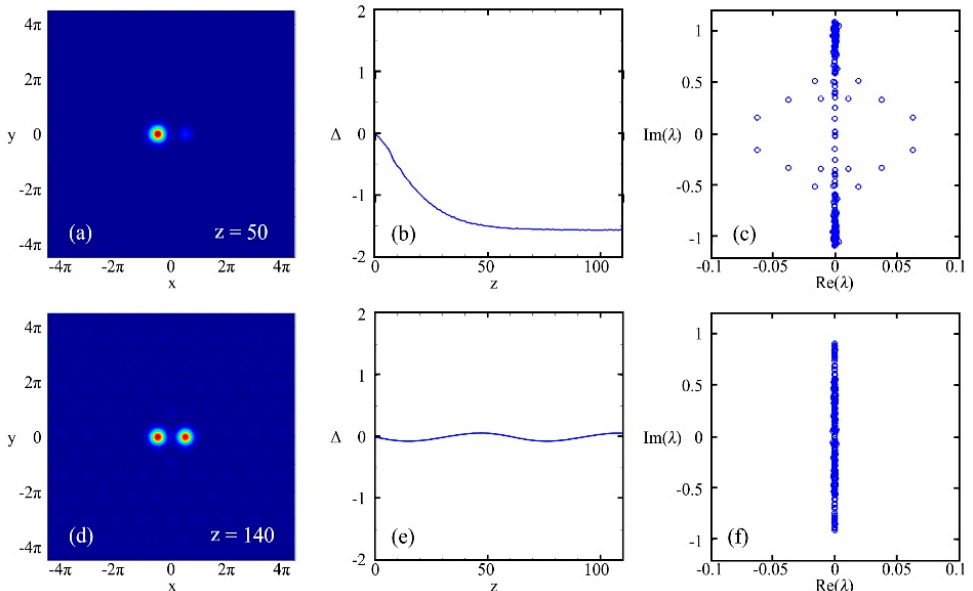
Figure 5. The evolution dynamics of strongly nonlocal dipole solitons. The first row corresponds to the unstable soliton with d = 2, µ = 7.6, and the second row corresponds to the stable soliton with d = 2, µ = 10. ( a , d ) show their transverse profiles. ( b , e ) show the changes of the gravity center, ∆ , during propagation. ( c , f ) show the spectrums of their perturbation growth rates.